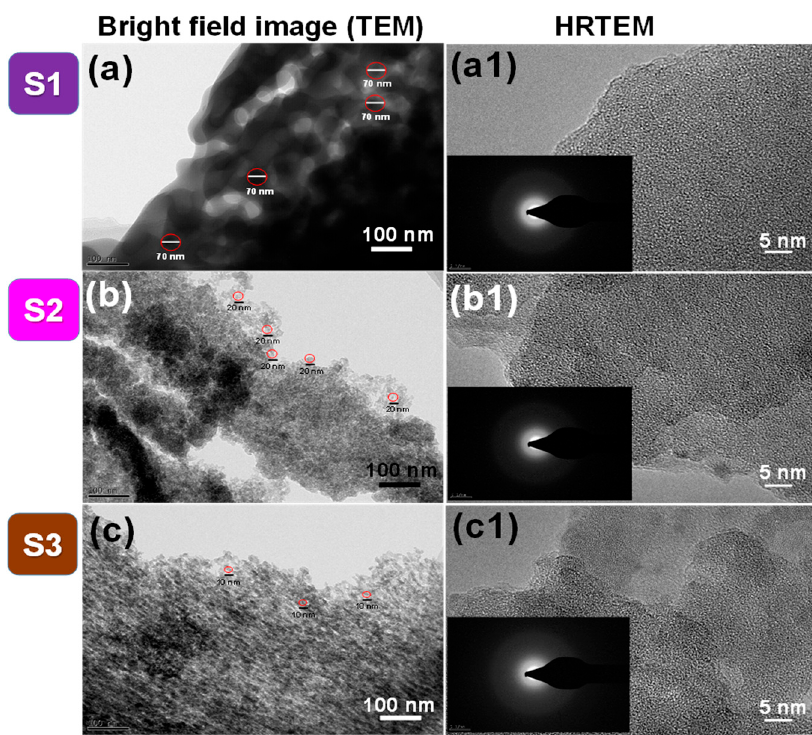
Figure 2. Analysis of S1, S2, and S3 nanopowders: ( a – c ) bright field transmission electron microscopy (TEM) images; ( a1 – c1 ) high resolution transmission electron microscopy (HR-TEM) images; the surface area electron diffraction (SAED) pattern of b-SiO 2 nanopowders are inset in figures of HR-TEM images.